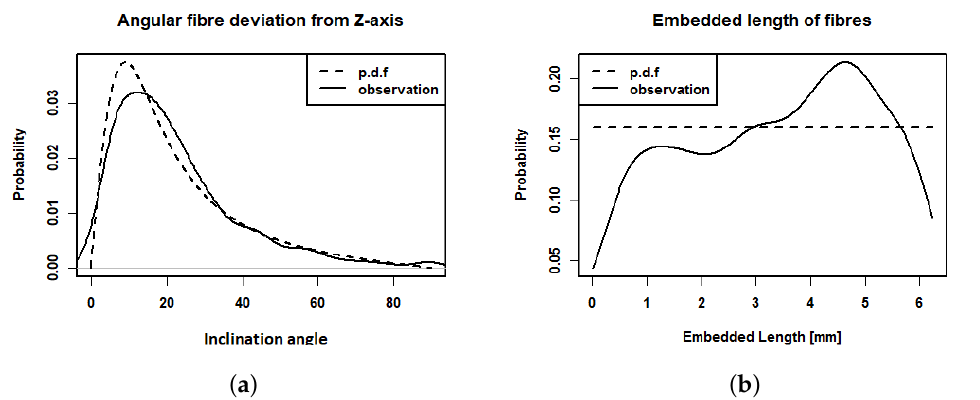
Figure 7. Observed inclination angle ( a ) and embedded length ( b ) of the fibres intersecting the crack (solid lines) and the corresponding fitted p.d.f. p c ( θ ) with β = 0.22 and p l